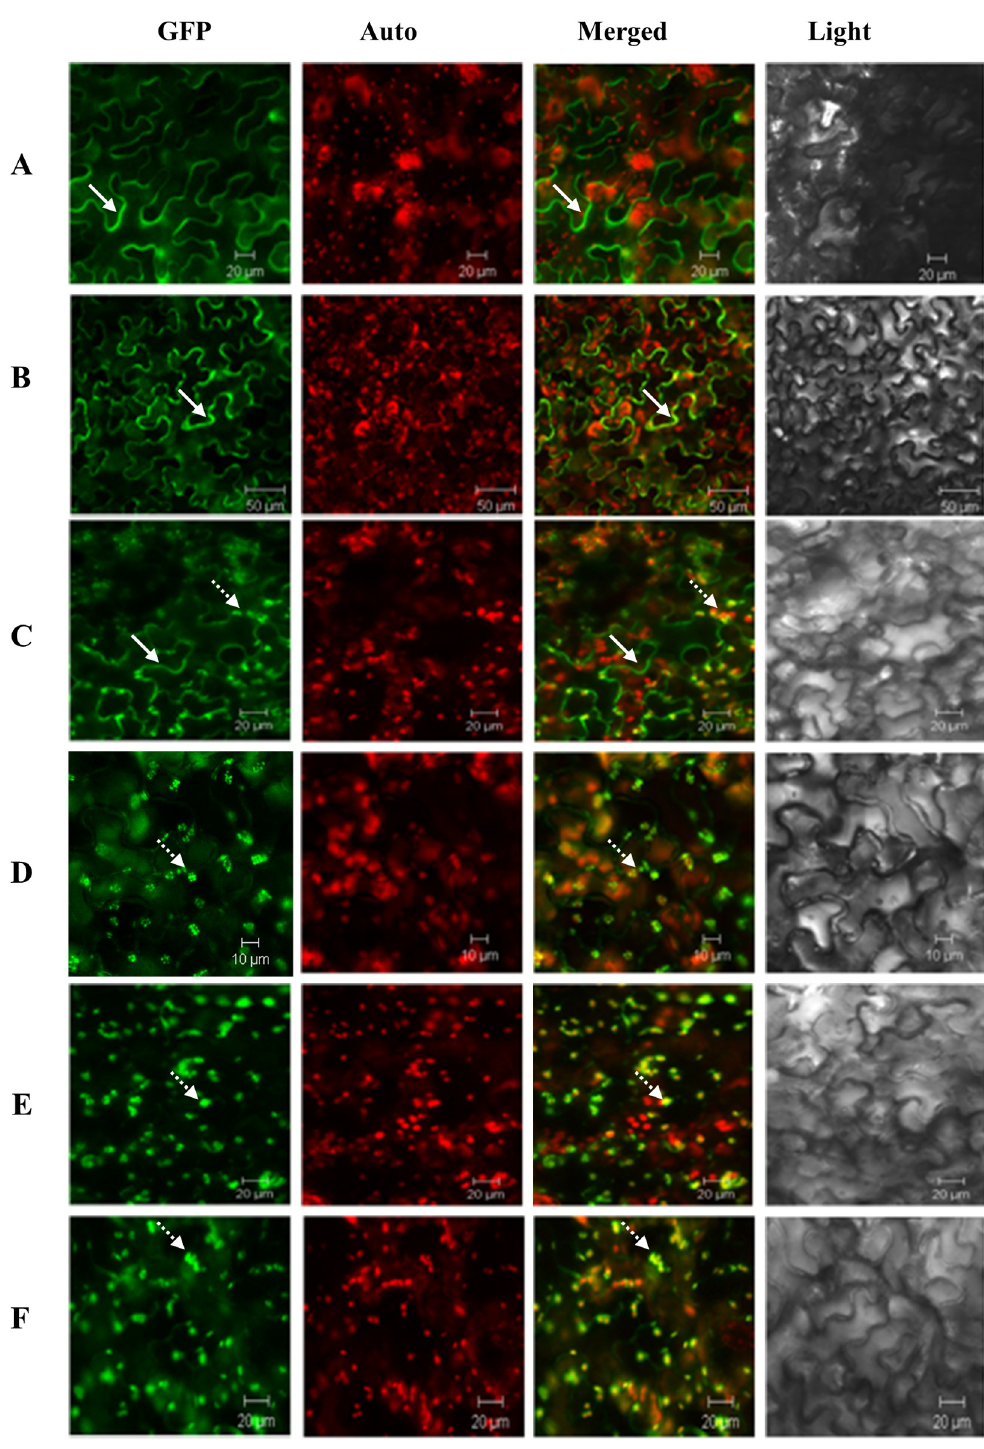
Fig 1. Localization of TP-FPS-GFP, TP-SaSSy-GFP, FPS-GFP, and SaSSy-GFP proteins in the leaves of Nicotiana benthamiana . (A) FPS-GFP located in the cytoplasm, scale bar = 20 μ m; (B) SaSSy-GFP located in the cytoplasm, scale bar = 50 μ m; (C) LTP-FPS-GFP located in both cytoplasm and chloroplasts, scale bar = 20 μ m; (D) LTP-SaSSy-GFP located in the chloroplasts, scale bar = 10 μ m; (E) RTP-FPS-GFP located in the chloroplasts, scale bar = 20 μ m; (F) RTP-SaSSy-GFP located in the chloroplasts, scale bar = 20 μ m. Solid arrow, GFP signal in cytoplasm; Dotted arrow, GFP signal in chloroplast; LTP, Solanum lycopersicum linalool synthase transit peptide; RTP, Arabidopsis thaliana ribulose bisphosphate carboxylase